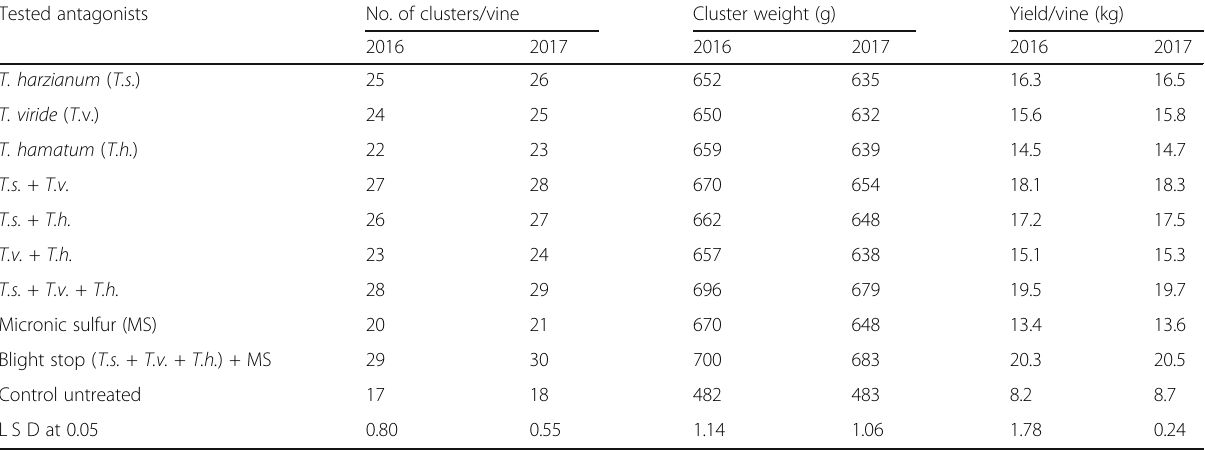
Table 2 Effect of different antagonists on powdery mildew of Thompson grapevine yield under Egyptian field conditions during 2016 and 2017 seasons Tested antagonists No. of